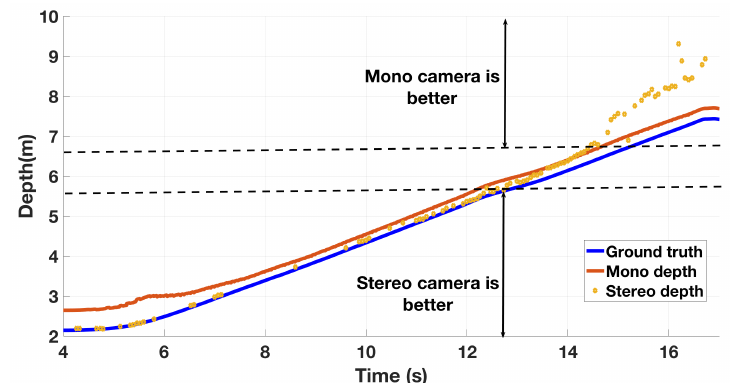
Figure 8. Depth estimation results for the stereo vision (amber) and motion parallax (red) approaches in the case of a peripheral point feature when the LOS angle is between 12 and 31 ◦ . The ground truth is shown by the blue line. The camera resolution is set to HD.